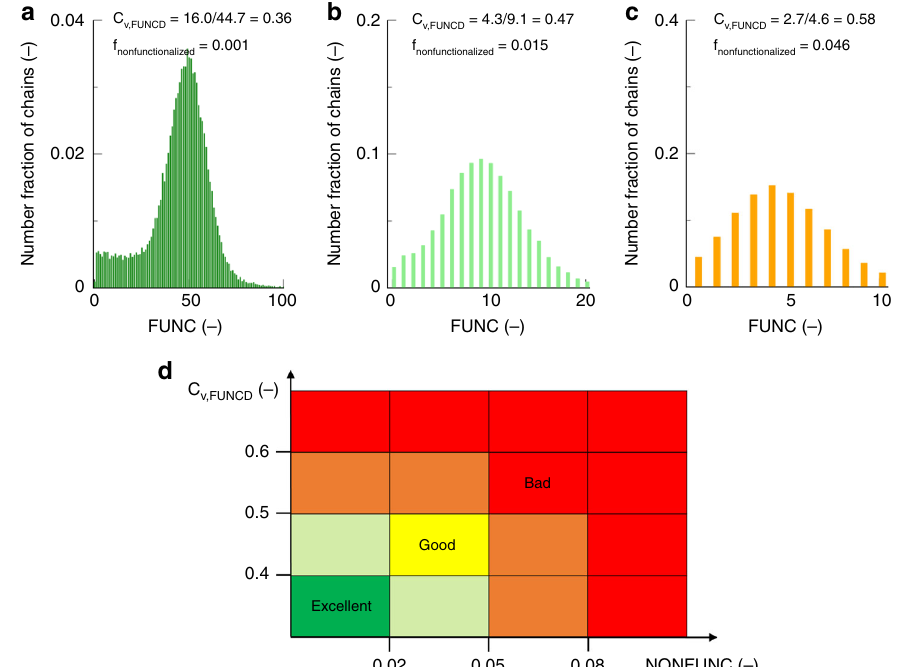
Fig. 7 Translation of functionalization distribution in two derived properties. a – c Functionality distribution (FUNCD) from FUNC-CLDs in Supplementary Fig. 15 ( f C2MestOx,0 = 50/10/5 mol %; 140 °C; target DP of 100). d associated color coding for a fast (guide of the eye) comparison of a functionalization success: full details see Supplementary Discussion (bad to excellent functionalization: dark red to dark green, with intermediate colors orange, yellow and light green); only with the extremely high initial amount of 50% an excellent functionalization (dark green) is